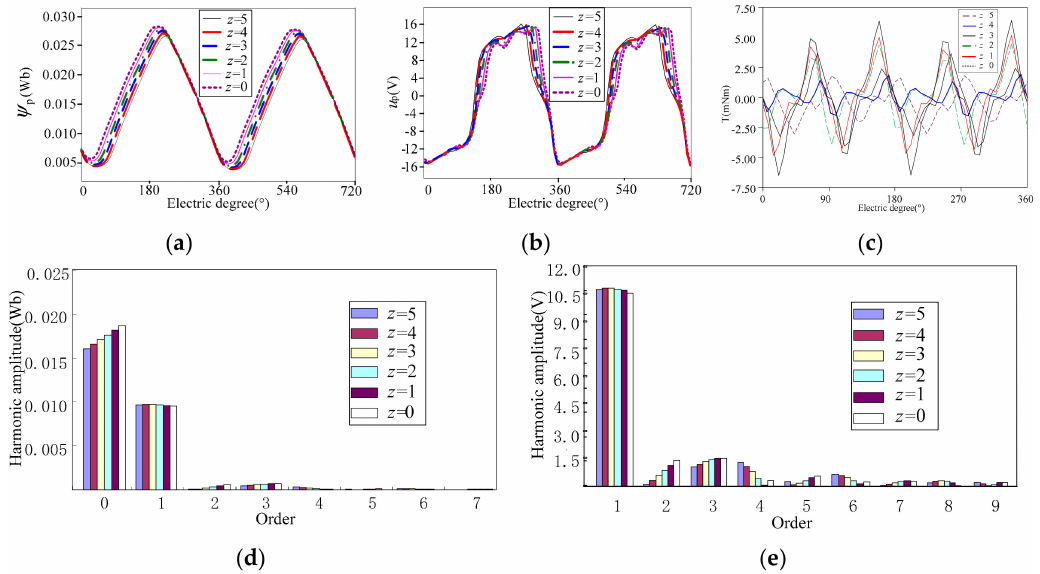
Figure 4. Influence of rotor arc length on WFDSGs. ( a ) Flux linkage when excitation current is 5A; ( b ) EMF when excitation current is 5A; ( c ) the cogging torque when excitation current is 1A; ( d ) harmonics of the flux linkage and ( e ) harmonics of the